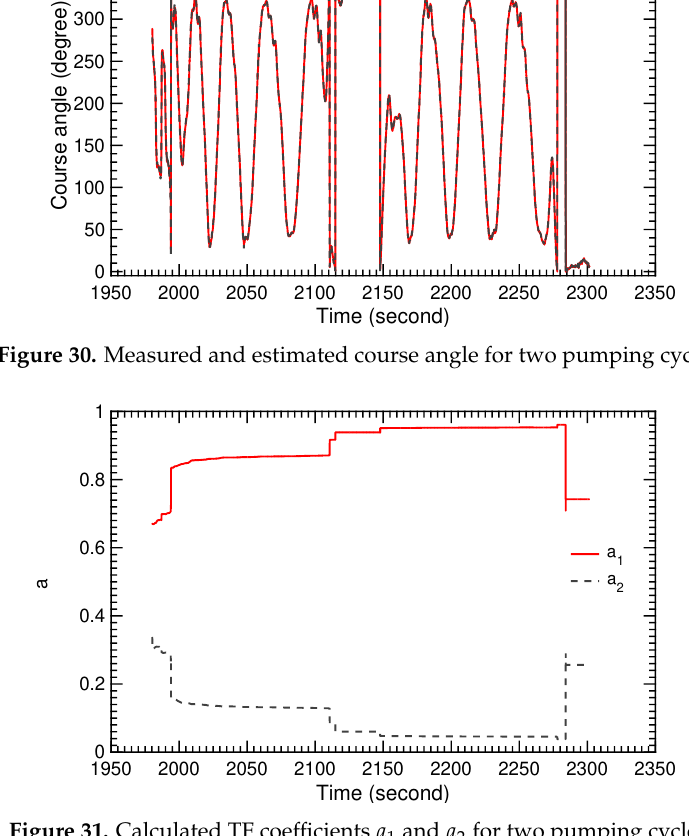
Figure 31. Calculated TF coefficients a 1 and a 2 for two pumping